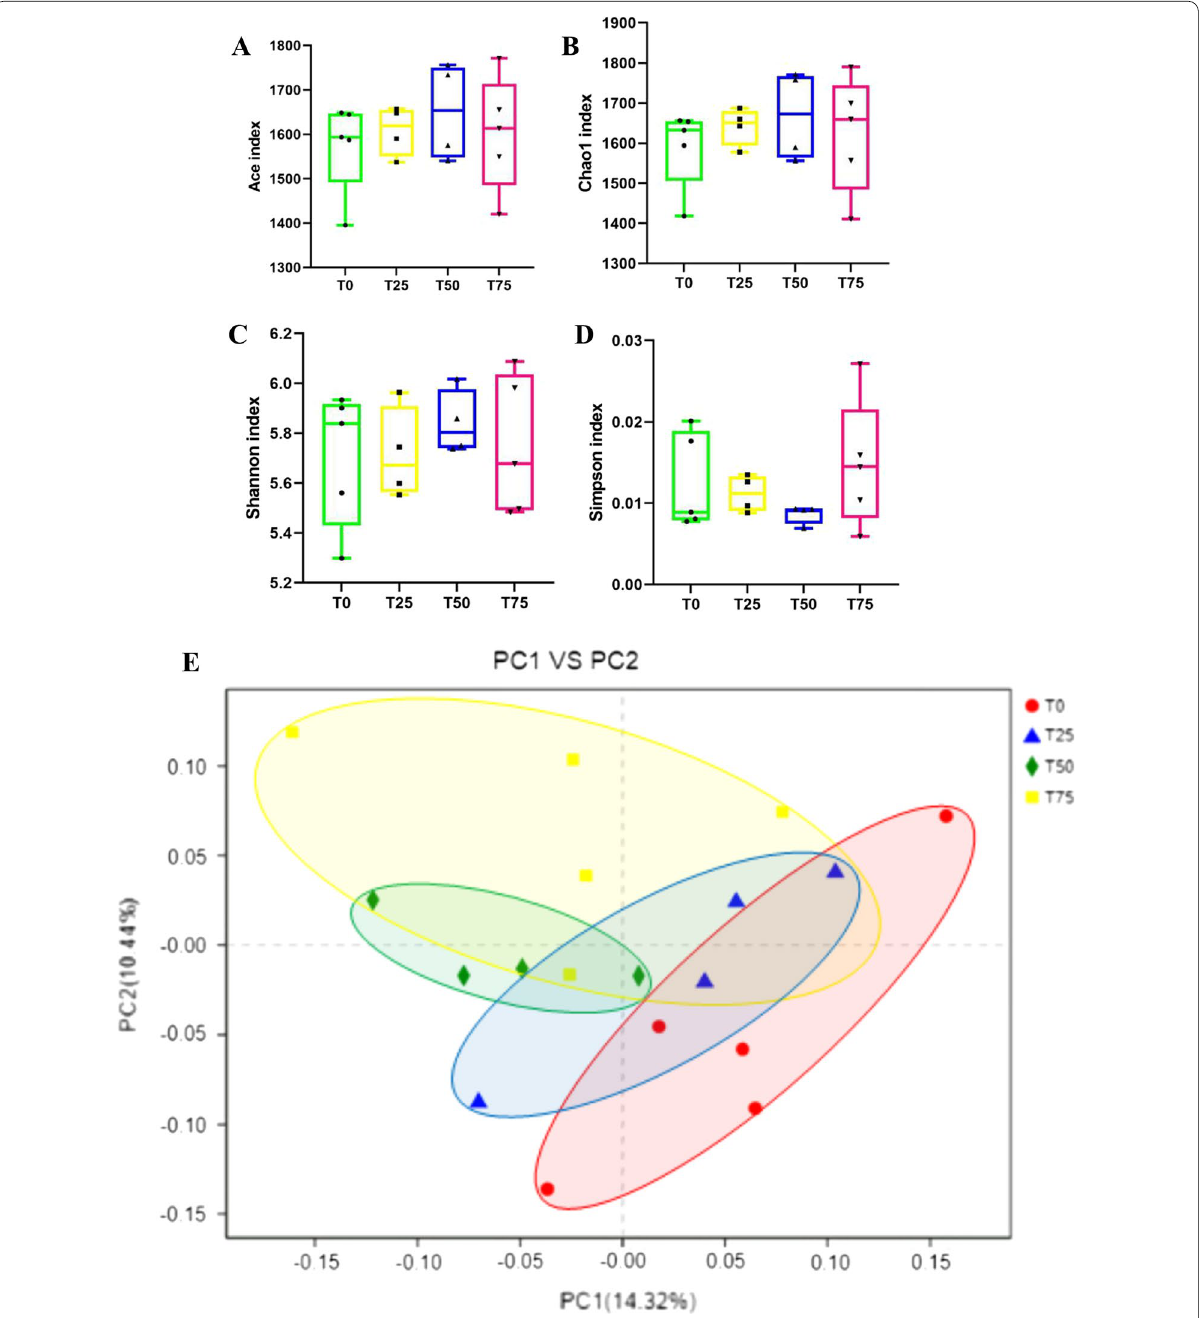
Fig. 1 Rumen microbiota diversity. A Chao1 index. B Ace index. C Simpson index. D Shannon index. E The Principal Co-ordinates Analysis